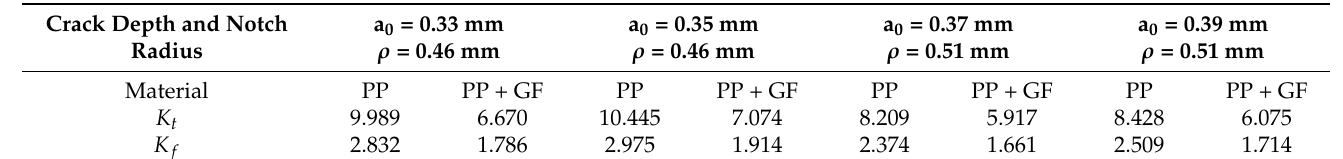
Table 8. Comparison of theoretical K t and K f between PP materials (with glass fiber) and PP materials (no glass fiber).